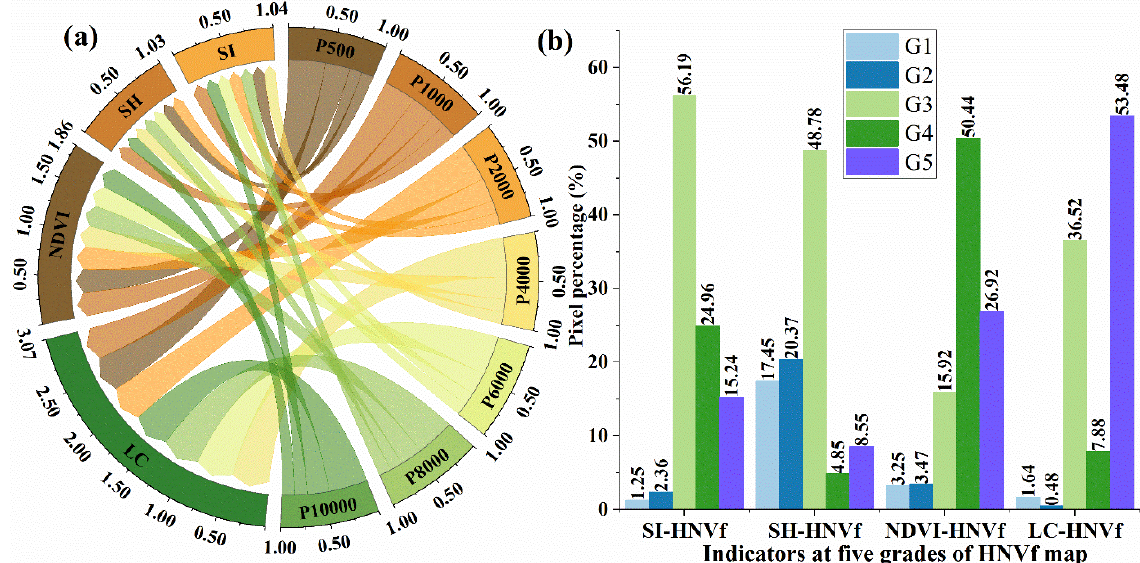
Figure 7. ( a ) The change in the importance contributions of LC, NDVI, SH and SI under different gradients for the random point; ( b ) the pixel percentages of the different indicators within the five levels of the HNVf map.